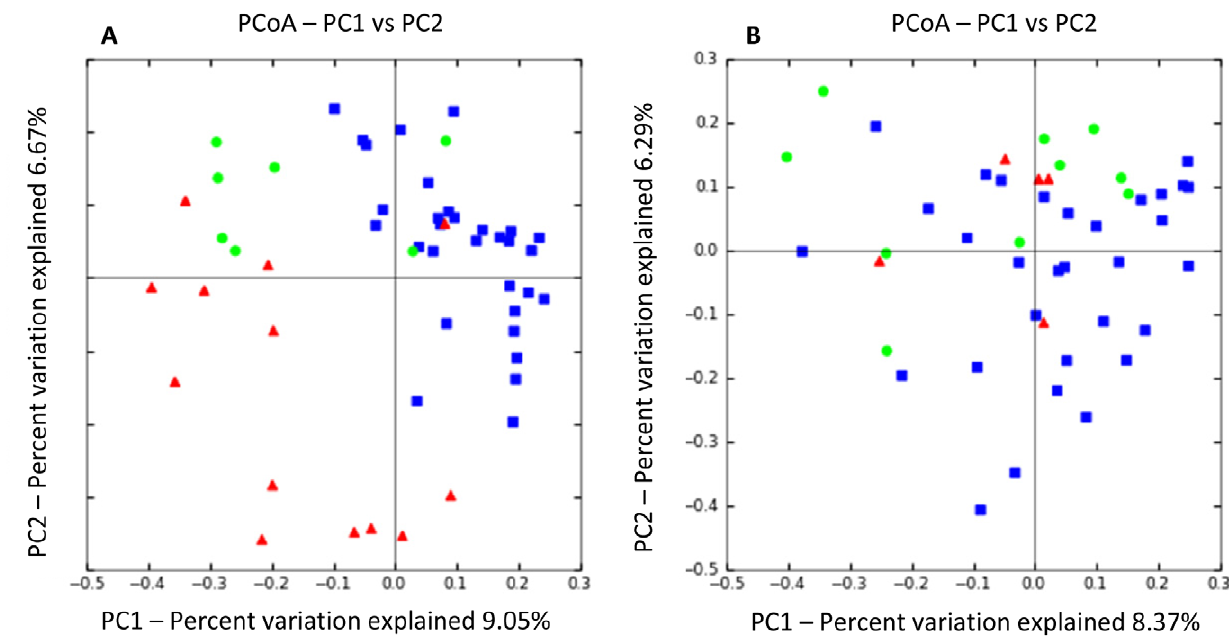
Figure 2. Principal Coordinates Analysis (PCoA) of unweighted UniFrac distances of 16 S rRNA genes. (A) Analysis for healthy dogs (blue), dogs with acute non-hemorrhagic diarrhea (NHD; green), and dogs with acute hemorrhagic diarrhea (AHD; red). These results indicate that fecal microbial communities differ in dogs with acute forms of diarrhea compared to healthy control dogs. Statistical analysis revealed a significant separation between samples obtained from NHD and AHD (ANOSIM; p=0.004) and both groups were also significantly different from the healthy dogs (ANOSIM; NHD vs. healthy dogs, p=0.003; AHD vs. healthy dogs, p=0.001). (B) Analysis for healthy dogs (blue), dogs with active IBD (red), and dogs with therapeutically controlled IBD (green). In contrast to the dogs with acute diarrhea, fecal communities in dogs with chronic forms of diarrhea (active idiopathic IBD) were not significantly different from healthy dogs in this study.